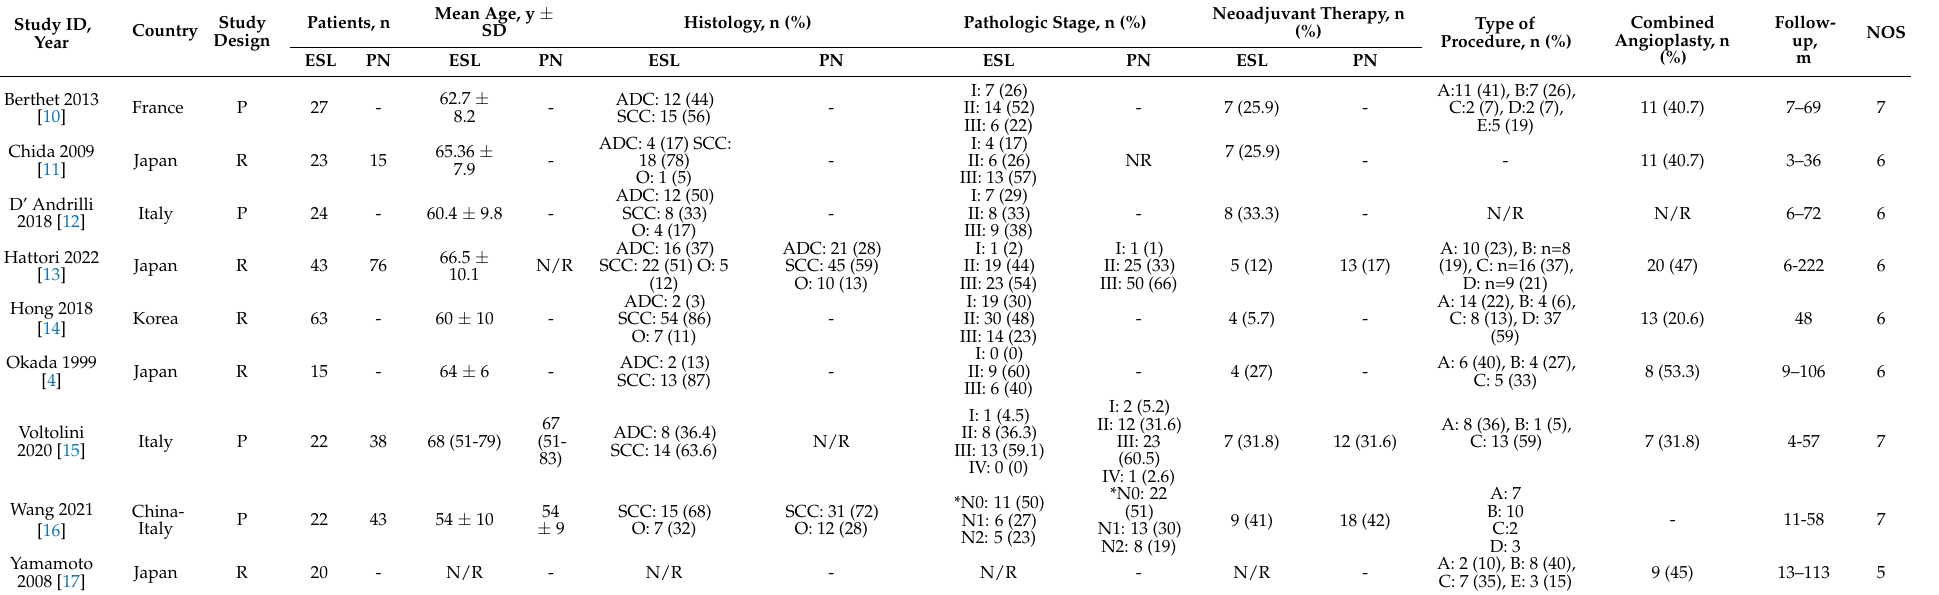
Table 1. Baseline characteristics of the studies and patients that were included in the